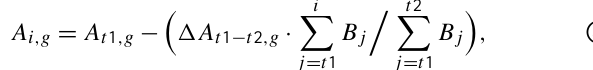
annual values proportional to mass balance